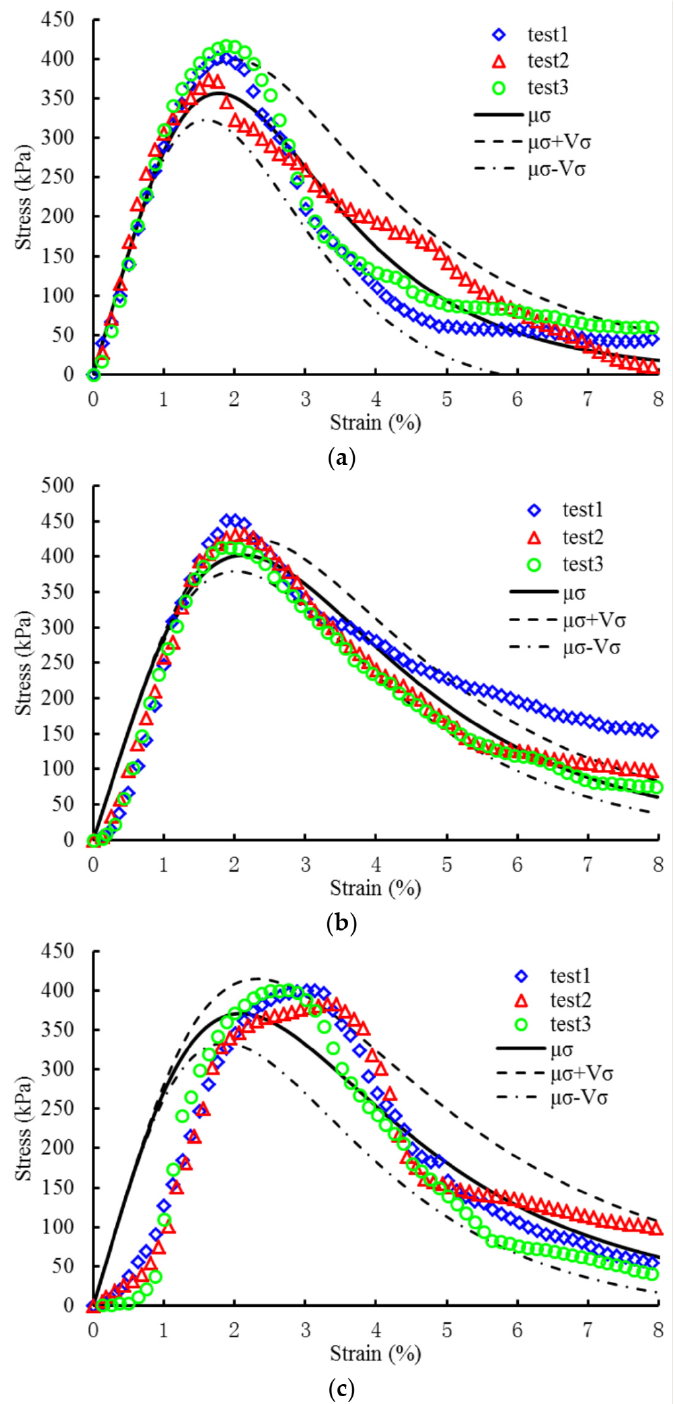
Figure 10. Fitting analysis diagram of F–T damage. ( a ) 0% fiber 0 F–T cycle; ( b ) 0.25% fiber 0 F–T cycle; ( c ) 0.5% fiber 1 F–T